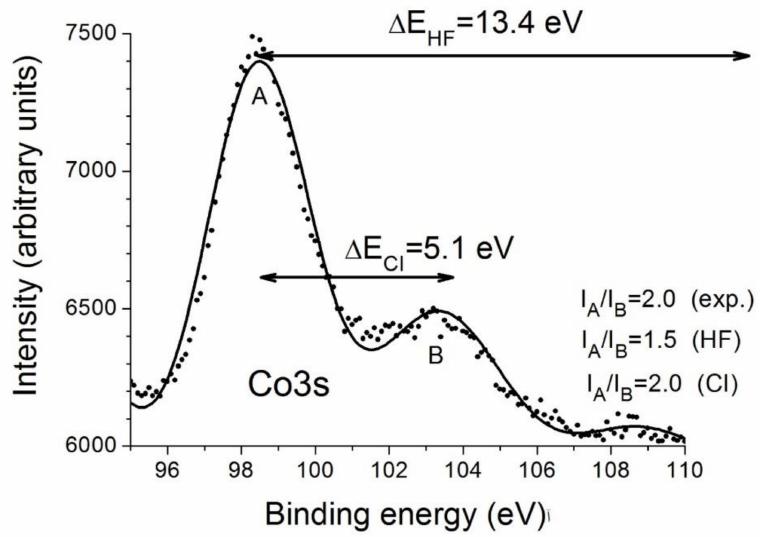
Figure 7. Experimental 3s-photoelectron spectrum of Co 3+ ion in paramagnetic BiCoO 3 [42]. Theoret- ical line splitting in HF approximation (HF) and with account for configuration interaction (CI) are also